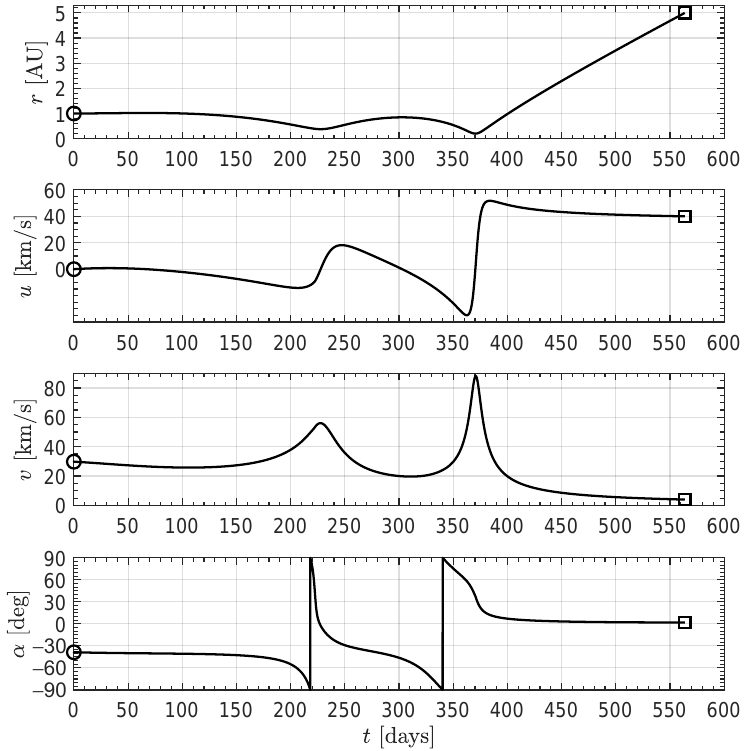
Figure 14. Heliocentric distance, velocity components and optimal steering law to reach a distance of 5au with V ∞ =